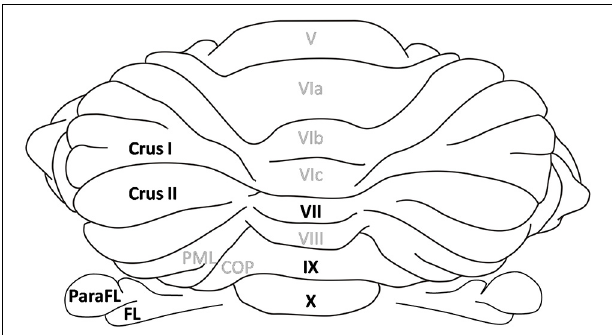
FIGURE 1 | Cerebellar lobules. Dorsal view of the rat cerebellum. Lobules in the vermis are numbered according to Larsell’s schema (Larsell, 1952). The lobules discussed in the review are highlighted in black. The flocculus and paraflocculus correspond to the hemispheric part of the flocculo-nodular lobe whereas lobules IX and X refer to its vermal part. Similarly Crus I and II are hemispheric regions in the posterior lobe whereas lobule VII is the corresponding vermal lobule. ParaFL, paraflocculus; FL, flocculus; PML, paramedian lobe; COP, copula